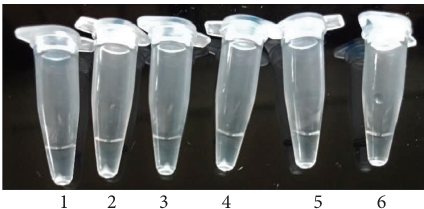
Figure 8: Determination of the fnal amplifcation products for the RVFV-UDG-RT-LAMP by observation of white precipitate. 1 -RVF 5335, 2- RVF G64, 3 -RVF-1984, 4 -RVF-64, 5- PPR , and 6 -NTC.